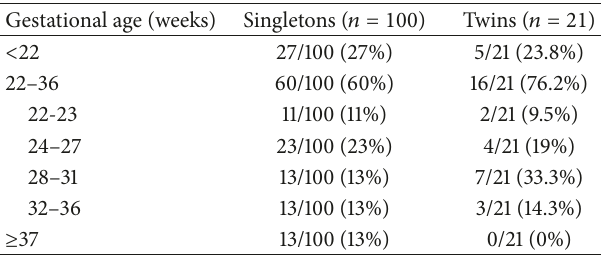
Table 4: Gestational age at delivery in the literature